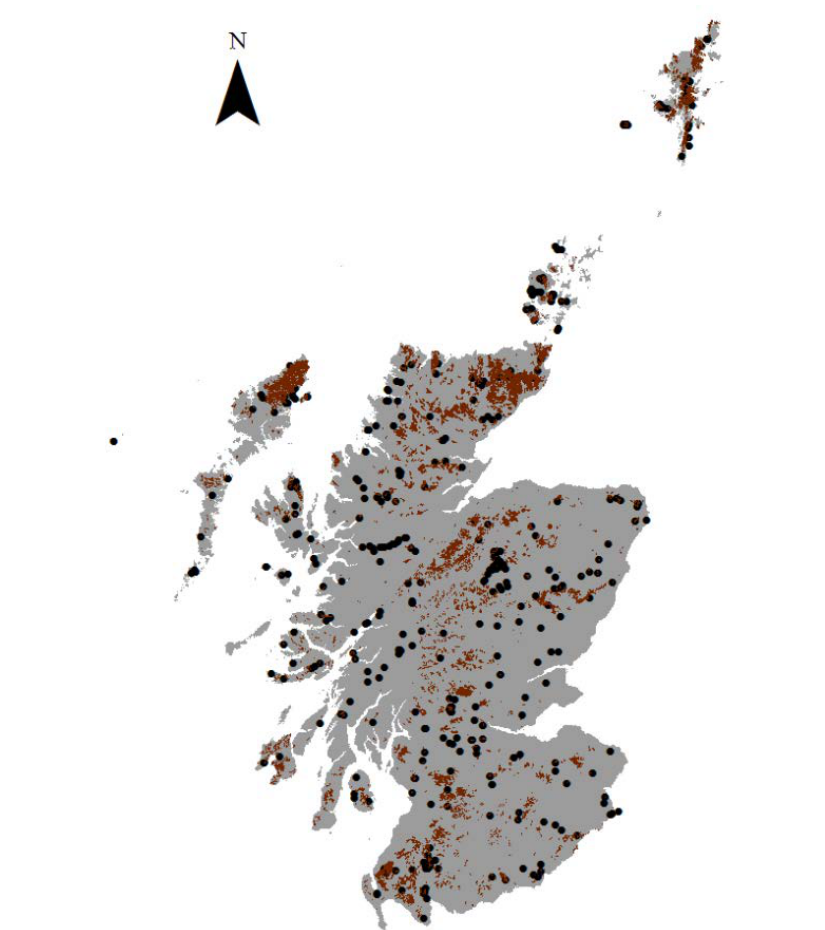
Figure 1. Map of Scotland (UK) showing the locations of sites with peat depth data from the palaeoecological literature (black filled circles). Brown polygons show areas recorded as predominantly peat in the 1:250,000 Soil Map of Scotland (MISR